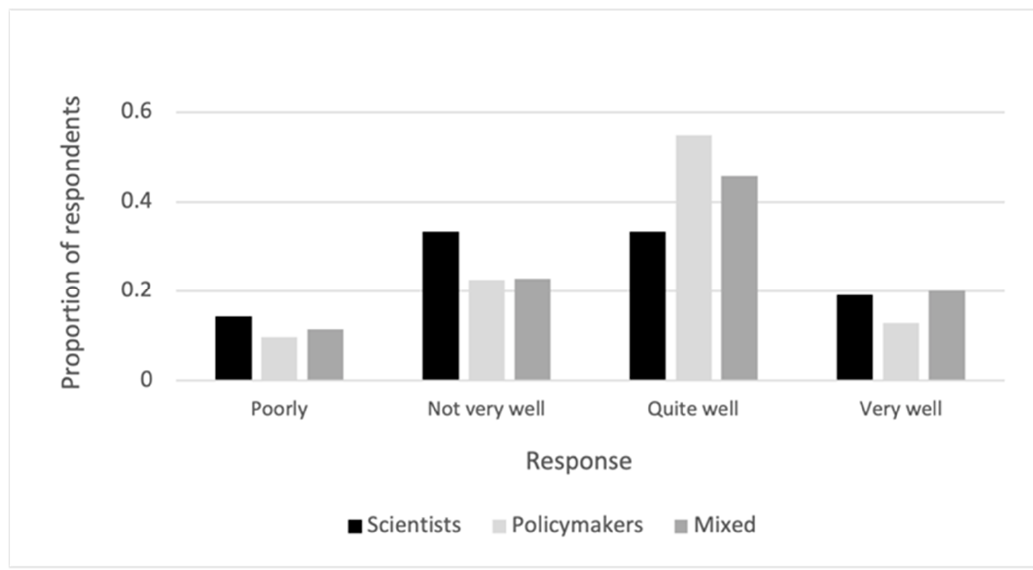
Figure 2. Distribution of responses given by scientists, policymakers, and mixed respondents to the question, “how well is (the best available) mechanism bridging the gap between policy and science?”.